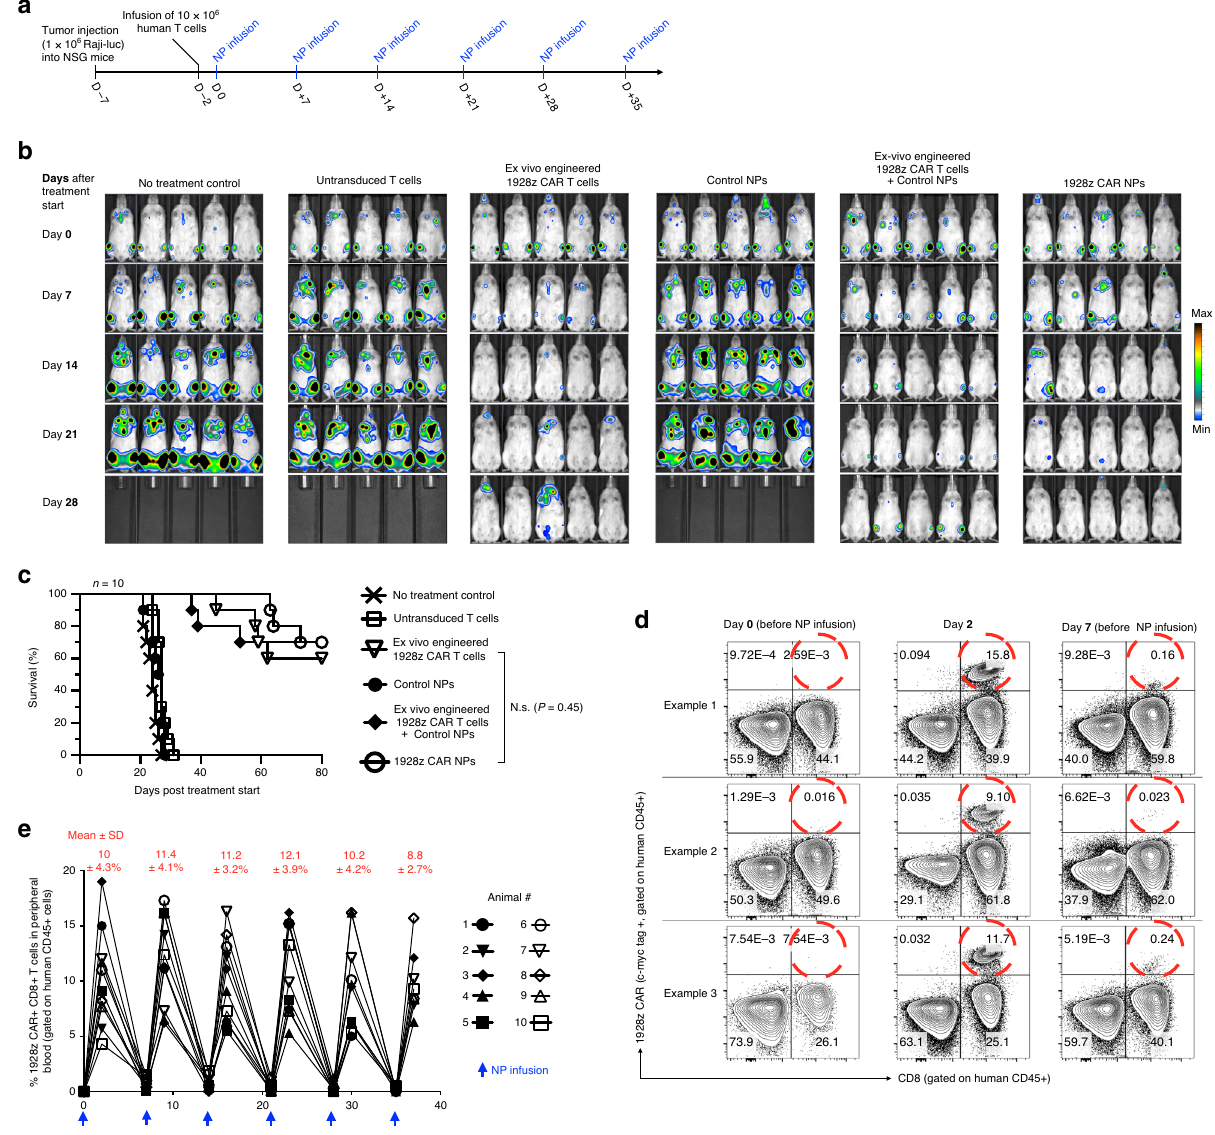
Fig. 4 Nanoparticle-programmed CAR lymphocytes can cause leukemia regression with ef fi cacies similar to adoptive T-cell therapy. a Time line and nanoparticle (NP) dosing regimen. b Sequential bioimaging of fi re fl y luciferase-expressing Raji lymphoma cells systemically injected into NSG mice. Five representative mice from each cohort ( n = 10) are shown. c Survival of animals following therapy, depicted as Kaplan – Meier curves. Shown are ten mice per treatment group pooled from three independent experiments. ms, median survival. Statistical analysis between the treated experimental and the untreated control group was performed using the Log-rank test; P < 0.05 was considered signi fi cant. d Flow cytometry of peripheral T cells before and after injection of nanoparticles delivering IVT mRNA that encodes the 1928z CAR. The three pro fi les for each time point shown here are representative of two independent experiments consisting of ten mice per group. e Overview graph displaying the percentages of CAR-transfected CD8 + T cells following repeated infusion of 1928z CAR NPs. Every line represents one animal. Shown are ten animals pooled from two independent experiments. Mean transfection ef fi ciencies (±SD) for each time point are shown at the